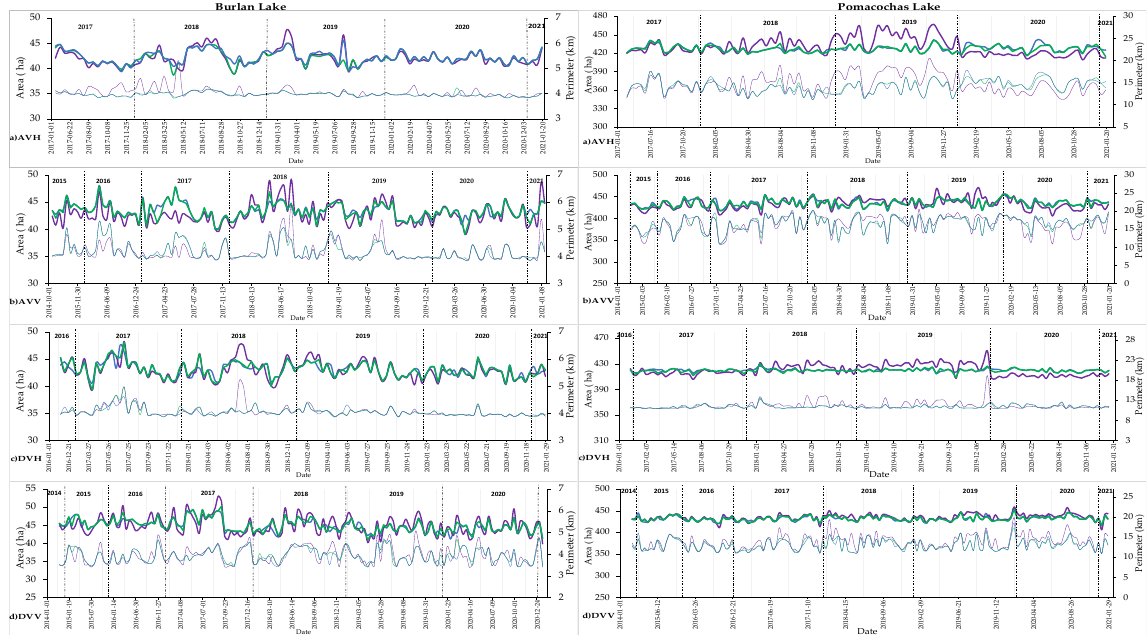
Figure 5. Variation in the area and perimeter of the Burlan and Pomacochas lakes using CART, RF, and SVM as classifiers of the SAR images. The thick lines represent the area (ha), and the thin lines represent the perimeter (km). In addition, the purple, green and blue lines represent the values obtained by SVM, CART and RF, respectively. In addition, AVH, AVV, DVH and DVV, represents the dataset obtained by: flight directions Ascending (A) and Descending (D), polarizations transmitted and received vertically (VV) and transmitted vertically and received horizontally (VH). Table 2 shows the minimum, maximum and average values obtained for the area (A) and perimeter (P) of Burlan and Pomacochas Lakes calculated according to the classifica- tion of SAR images using CART, RF, and SVM. The behaviour of the values obtained by CART and RF was similar for both lakes, while the SVM values were much higher, due to the algorithm used in the classification. Table 2. Minimum, maximum, and average values of the area and perimeter of the Burlan and Pomacochas lakes obtained by classification of SAR images in the 2014–2020 period. Classifier Geometric Attribute